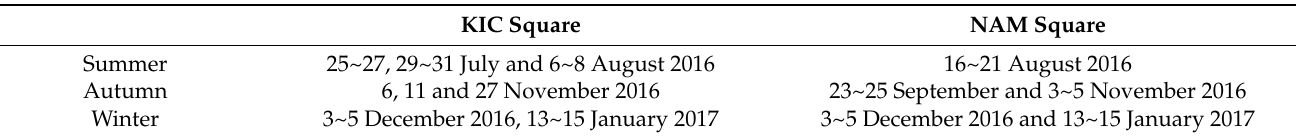
Table 1. The date of the